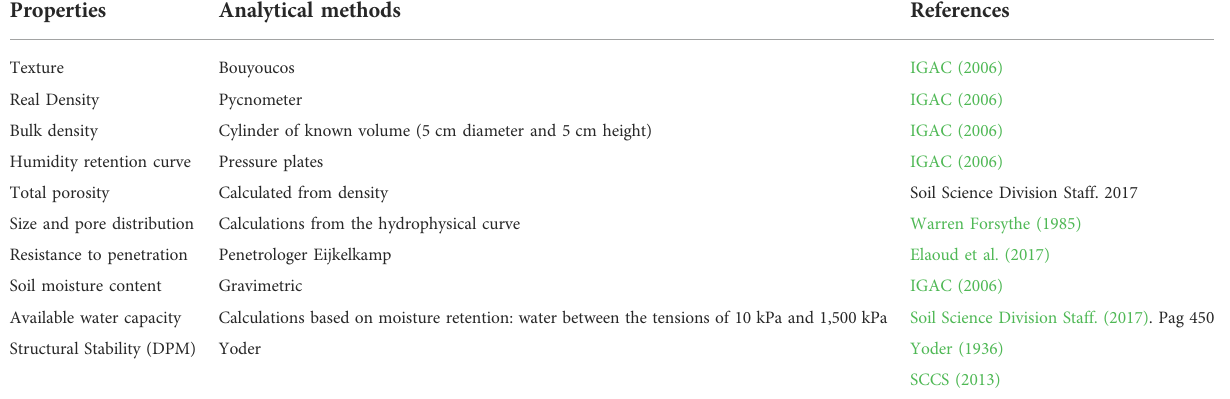
TABLE 4 Analytical methods used for the determination of soil physical